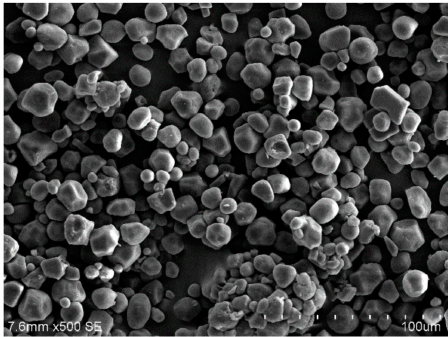
Figure 13. Scanning electron microscope (SEM) image of CMS